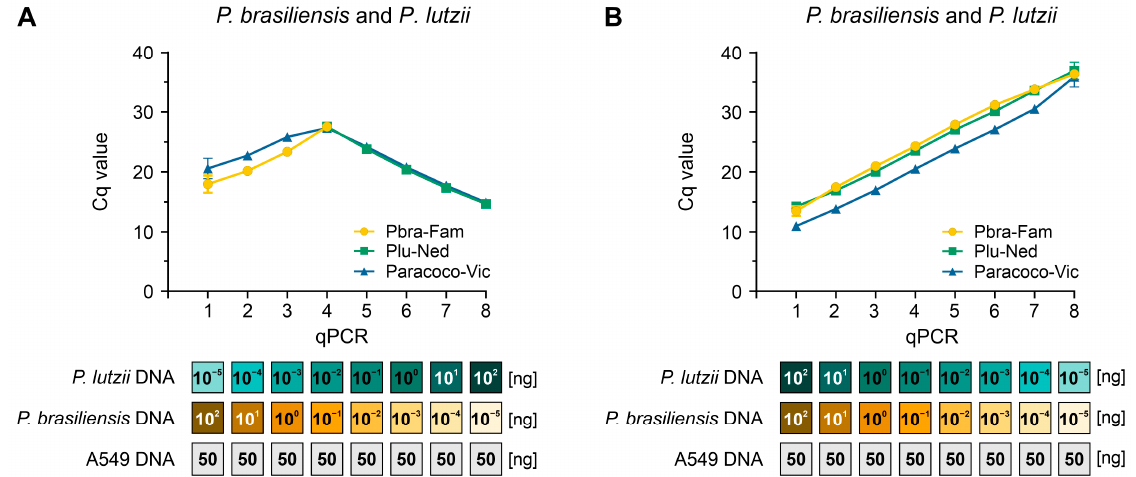
Figure 5. Assessment of target/template competition. ( A ) Using a triplex-probe qPCR assay, we combined the gDNA of P. brasiliensis (Pb18) and P. lutzii (Pb01) in a manner that the highest DNA concentration for the first species in the curve was mixed with the lowest concentration in the opposite species’ curve. ( B ) P. brasiliensis (Pb18) and P. lutzii (Pb01) gDNA were added to the triplex-probe qPCR assay in equimolar amounts. All qPCRs were run in the presence of 50 ng human DNA. The results are typical of two separate experiments.